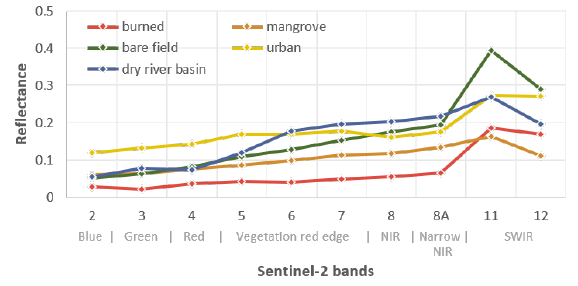
Figure 6 . Example spectral signatures of burned areas and land cover types prone to misclassifications.